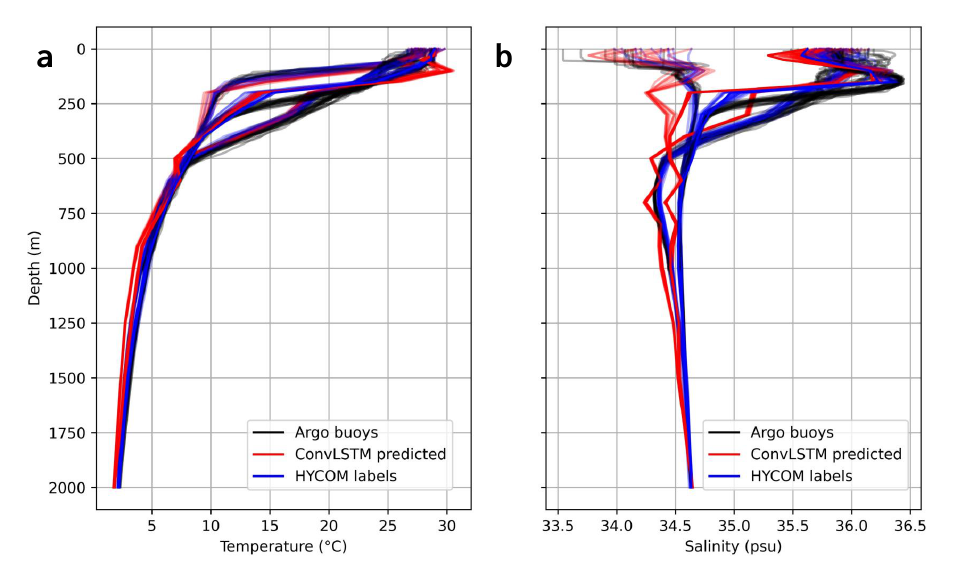
Figure 13. The vertical profiles of some grid points in the study area for ( a ) ST, ( b )